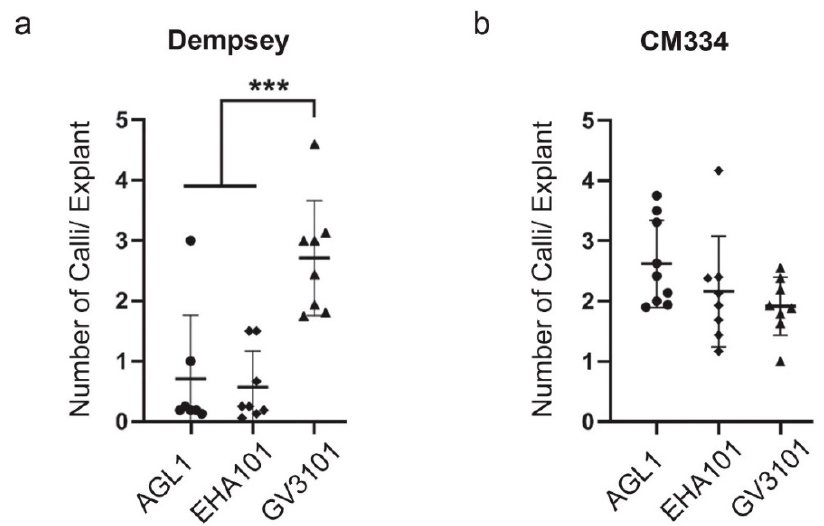
Figure 2. Comparison of callus induction ratios among the three Agrobacterium strains in Agrobacterium -mediated transformation of two pepper types. ( a ) Callus induction ratios of cv. Dempsey by three Agrobacterium strains (AGL1, n = 7 biological replicates (BR); EHA101, n = 8 BR; GV3101, n = 8 BR). Total number of explants was 265. Results are presented as mean ± SD; ( b ) Callus induction ratios of cv. CM334 by three Agrobacterium strains (AGL1, n = 9 BR; EHA101, n = 8 BR; GV3101, n = 8 BR). Total number of explants was 328. Results are presented as mean ± SD. Callus size ≥ 2.5 mm. ***, p < 0.001 based on analysis of variance (ANOVA). 2.3. Suitable Phosphinothricin (PPT) Concentration for Screening Transformants in cv. Dempsey and